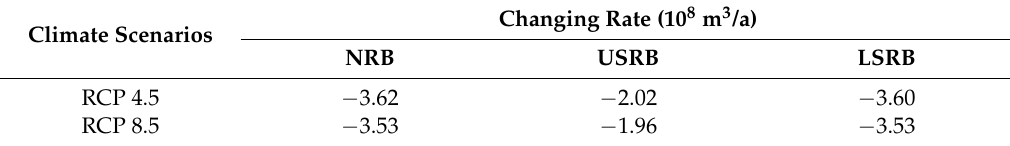
Table 5. Trends of future streamflow in the Nenjiang River (NRB), Upper Songhua River (USRB), and Lower Songhua River (LSRB) sub ‐ basins of the Songhua River Basin under two climate change scenarios.